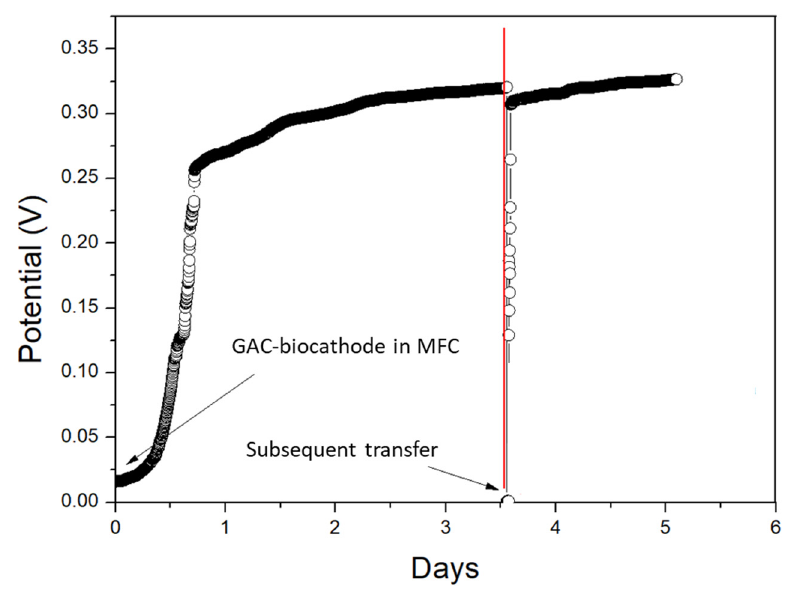
Figure 3. The potential generation from the MFC with the GAC-biocathode. The enriched GAC showed instant potential generation in the MFC with no lag phase.